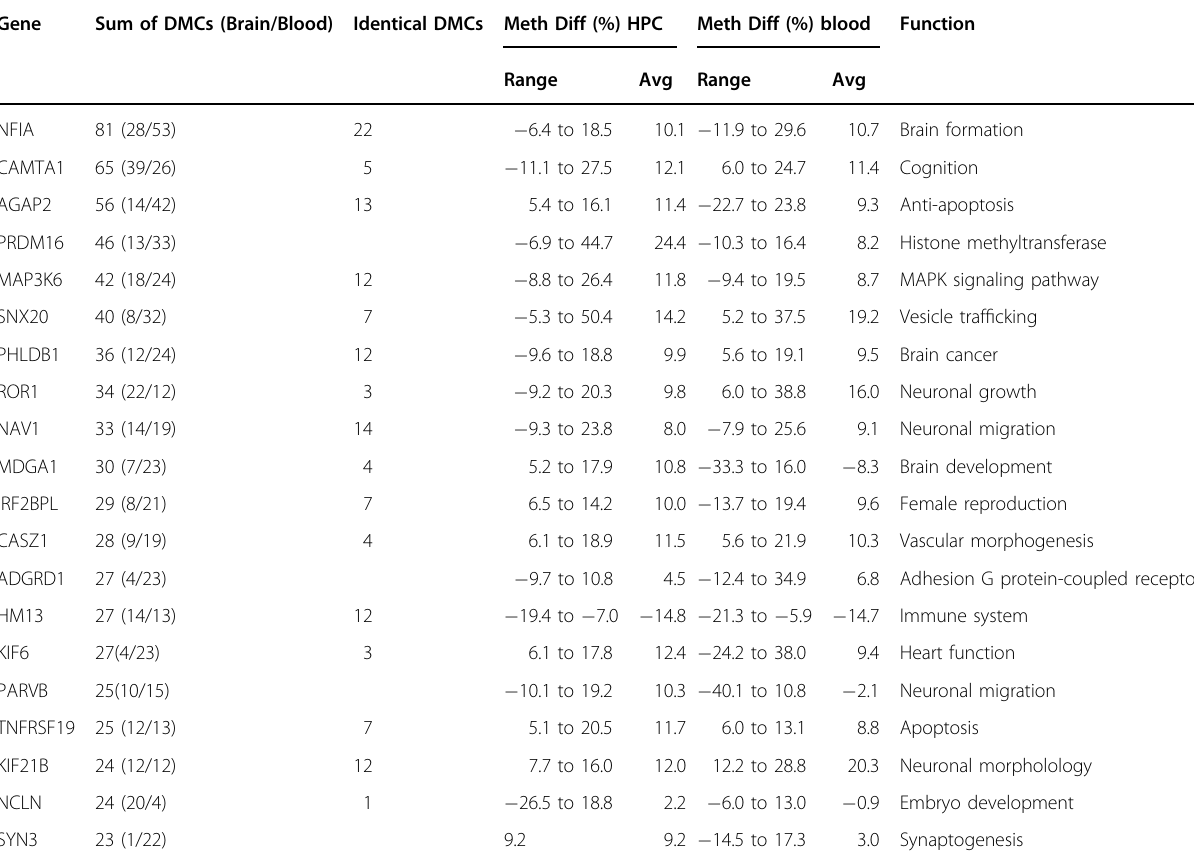
Table 1 List of 20 top genes that showed DMCs in common between the hippocampus (HPC) and whole blood samples, rank-ordered by the greatest number of DMCs combined between the two tissue types.